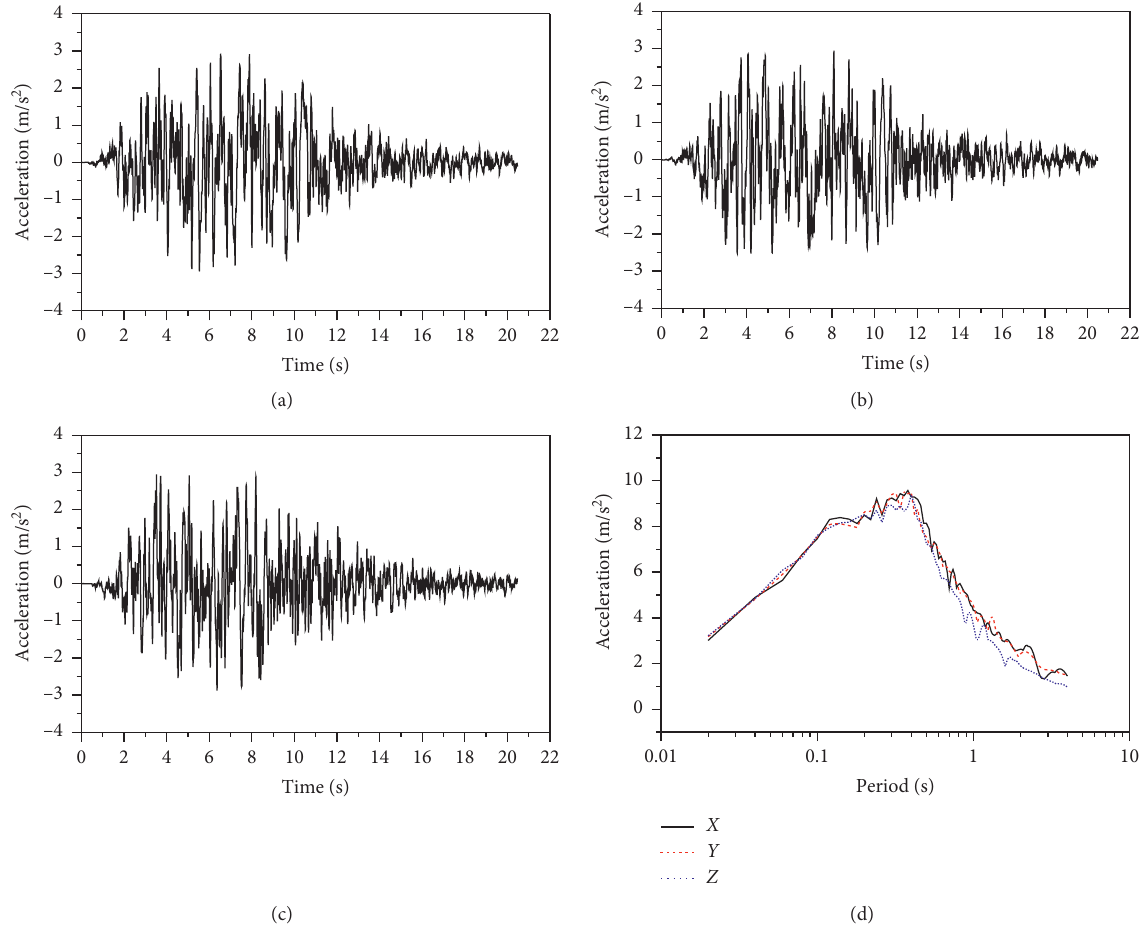
Figure 6: Artificial ground motion: (a) acceleration time history in X -direction, (b) acceleration time history in Y -direction, (c) acceleration time history in Z -direction, and (d) response spectra.